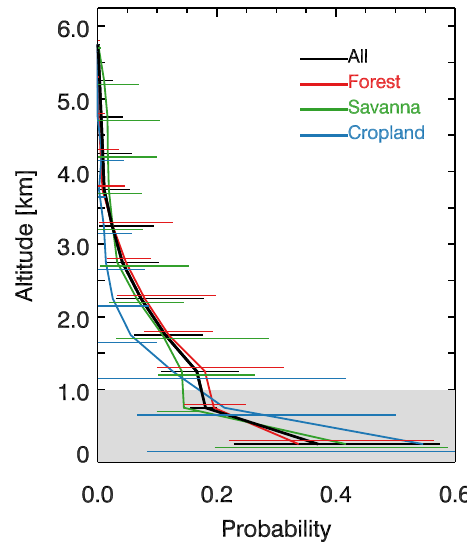
Fig. 2. Probability distribution of all smoke pixel heights from smoke plumes observed by MISR during February to April for the years 2001–2010 (black line). The grey area below 1km al- titude indicates the mean local boundary layer at Terra overpass time (10:30 local time) in the MERRA assimilated meteorology data set. Also shown are probability distributions for smoke pixel heights associated with different land covers: evergreen and decidu- ous broadleaf forest (red), woody savanna (green), and cropland and cropland/natural vegetation mosaic (blue). The error bars show the range of probability for individual years between 2001 and